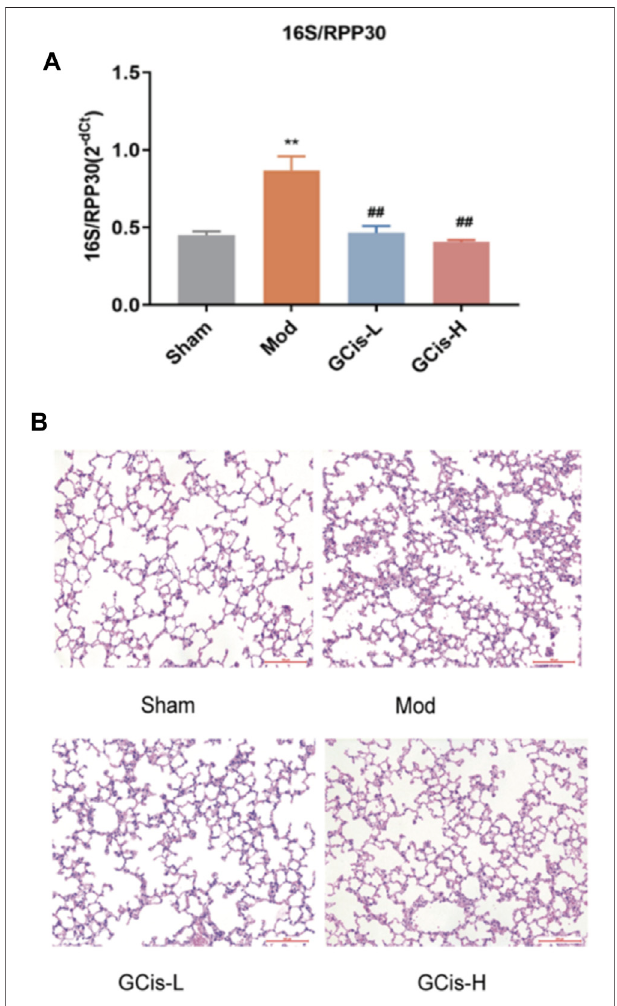
FIGURE2| GCisformulapretreatmentamelioratedpulmonaryinfection. (A) Q-PCR 16S/RPP30 was measured by qRT-PCR. (B) Typical histological images of H&E-stained lung tissues (magni fi cation ×100). Data are shown as mean ± SEM. ** p < 0.01 compared with the SHAM group; ## p < 0.01 compared with the model